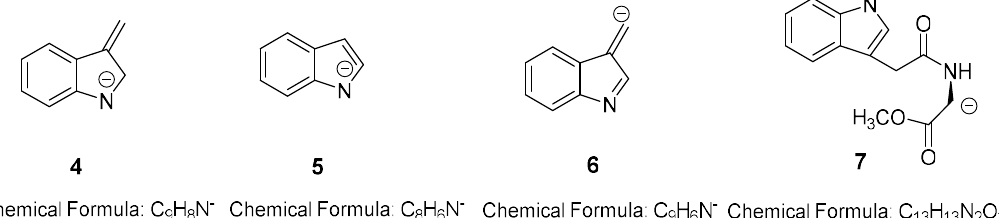
Figure 4. Fragments of 3-substituted indole compounds in the negative ion mode.